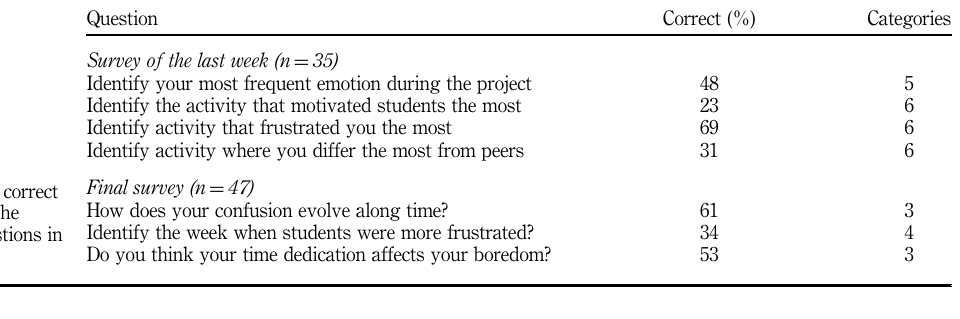
Figure 6. SUS scores obtained for all visualizations during the four weeks of the user